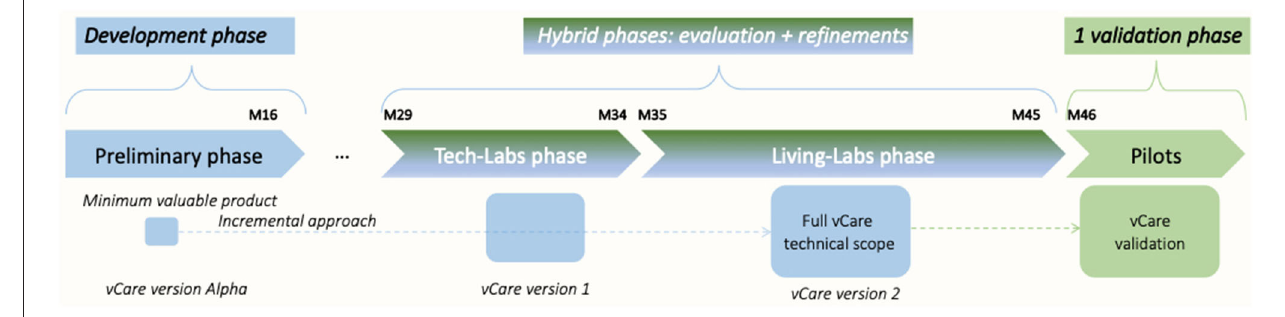
FIGURE 7 | Overall implementation